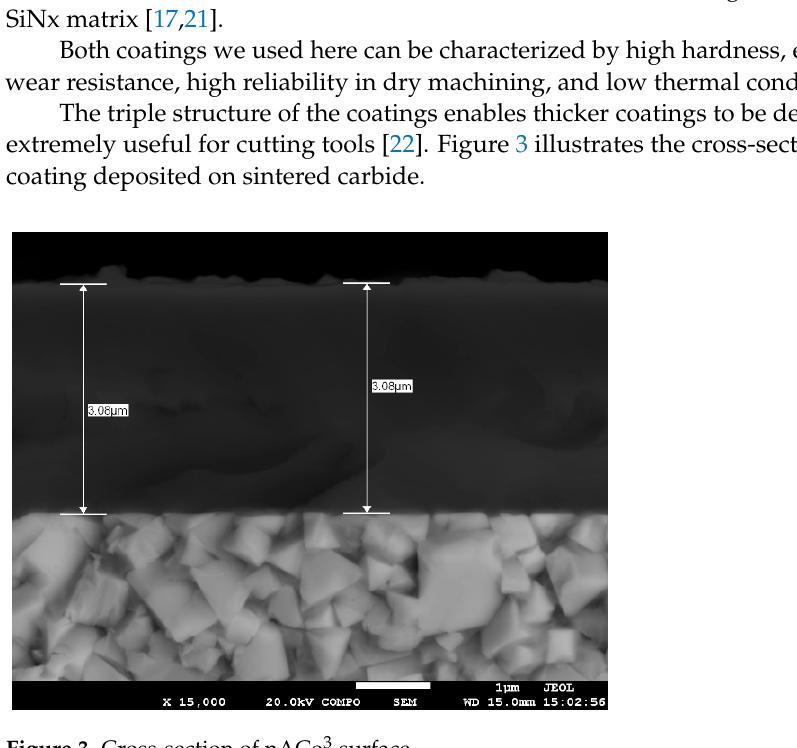
Figure 3. Cross-section of nACo 3